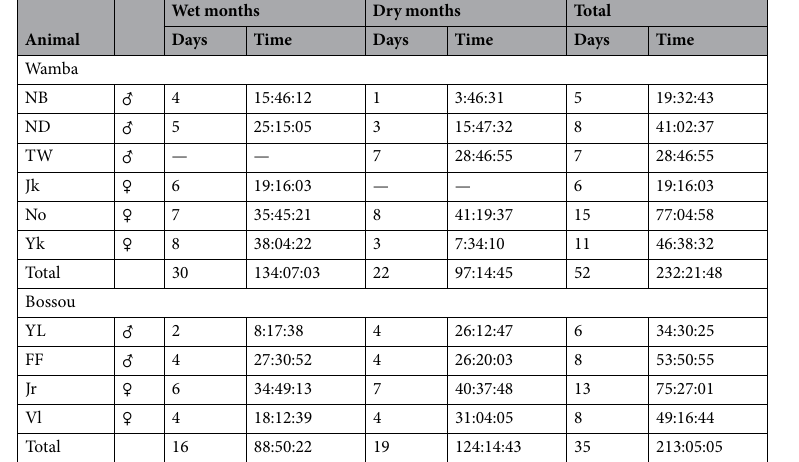
Table 3. Observation days and time for each focal